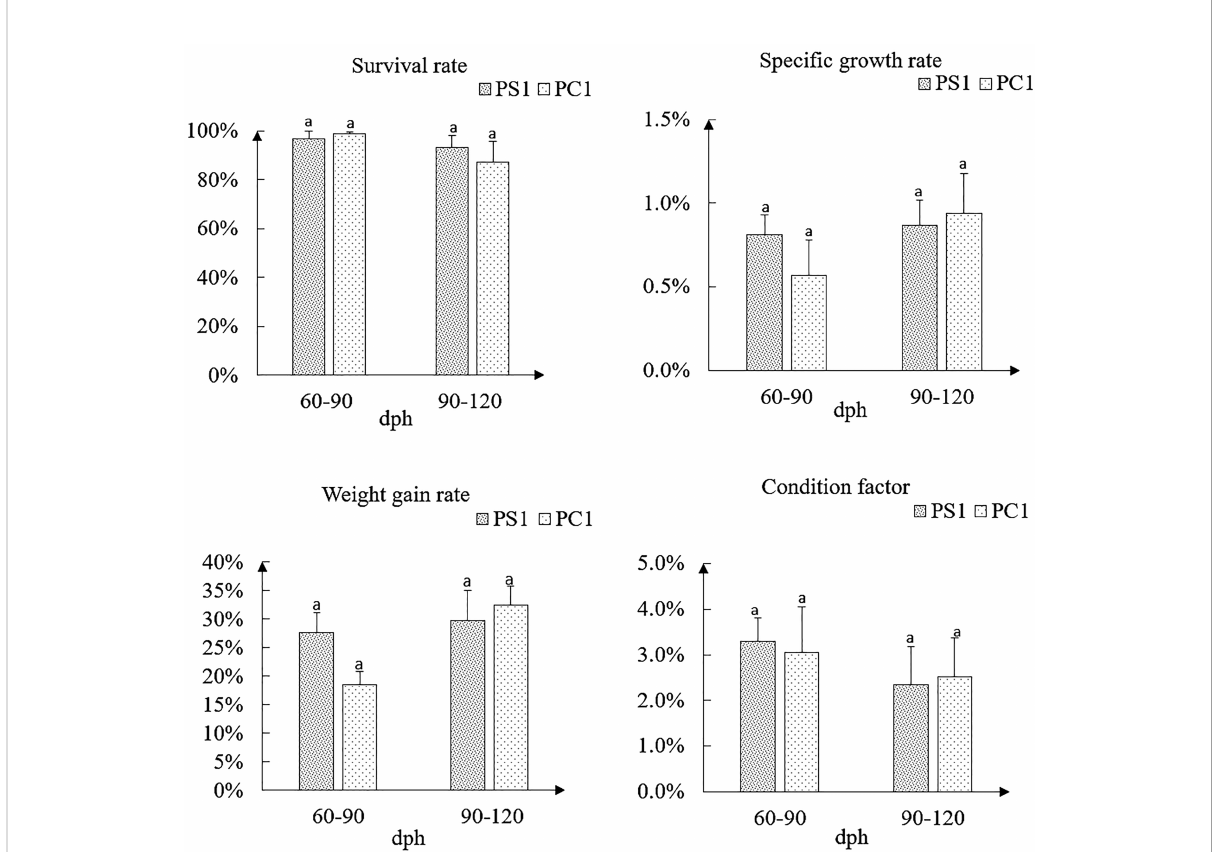
FIGURE 1 Growth performance parameters of Pampus argenteus from selected group and control group at different